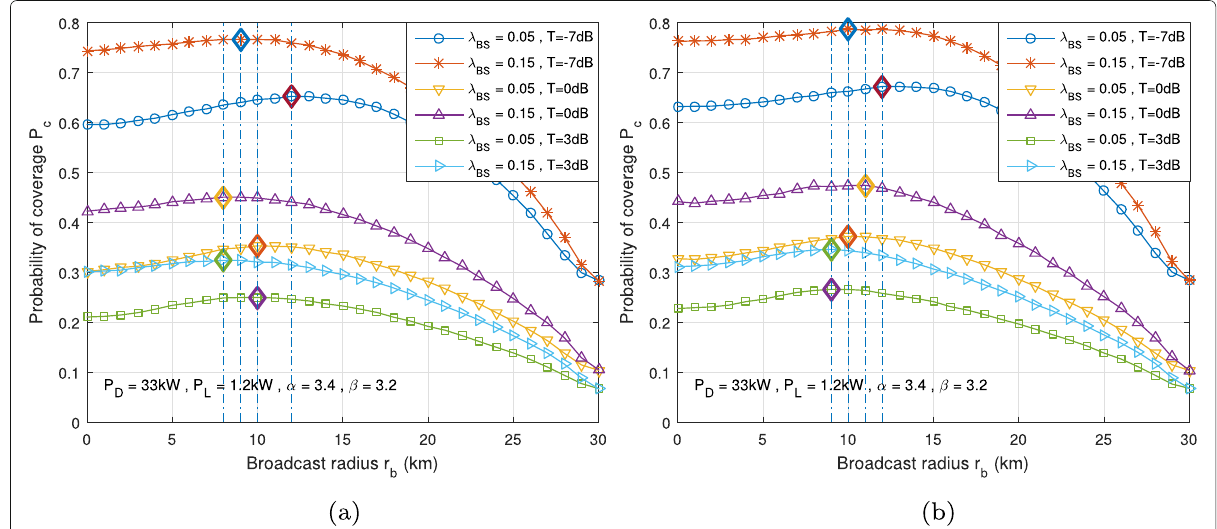
Fig. 7 Probability of coverage for both scenarios vs. the BC radius r b for − 105 dBm noise power. a Shared spectrum scenario b Dedicated spectra scenario